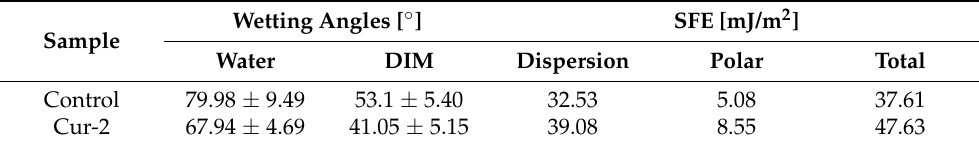
Table 5. Wetting angles and surface free energy (SFE) for the control film and Cur-2 film.